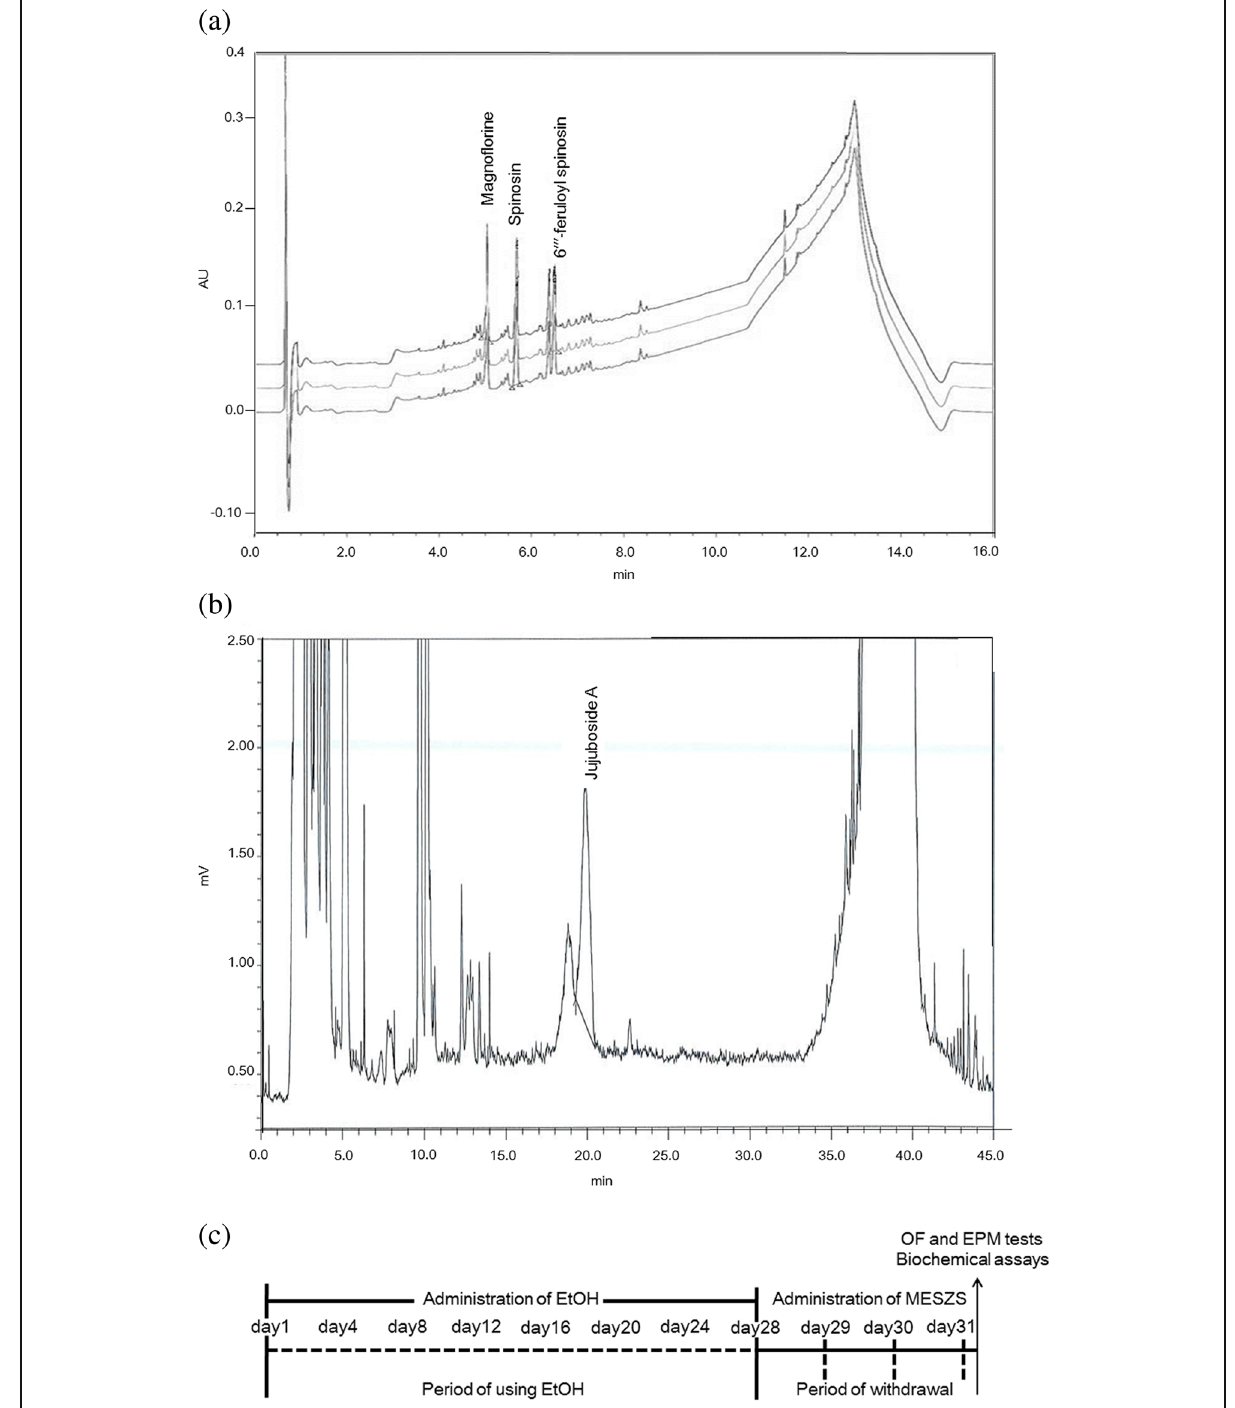
Fig. 1 ( a ) HPLC profile of MESZS, which includes magnoflorine, spinosin, and 6 ′′′ -feruloyl spinosin. ( b ) HPLC profile of MESZS, which includes Jujuboside A. ( c ) Time schedule for ethanol withdrawal (EtOHW). Rats were given with EtOH (2 g/kg, dissolved in saline, i.p., once a day) for 28 consecutive days followed by 3 d of withdrawal and then evaluated for behavioral and biochemical changes. During the EtOHW, the rats were administered with MESZS (60 or 180 mg/kg/d, three times). MESZS: methanol extract of Semen Ziziphi Spinosae ; OF: open field; EPM: elevated plus